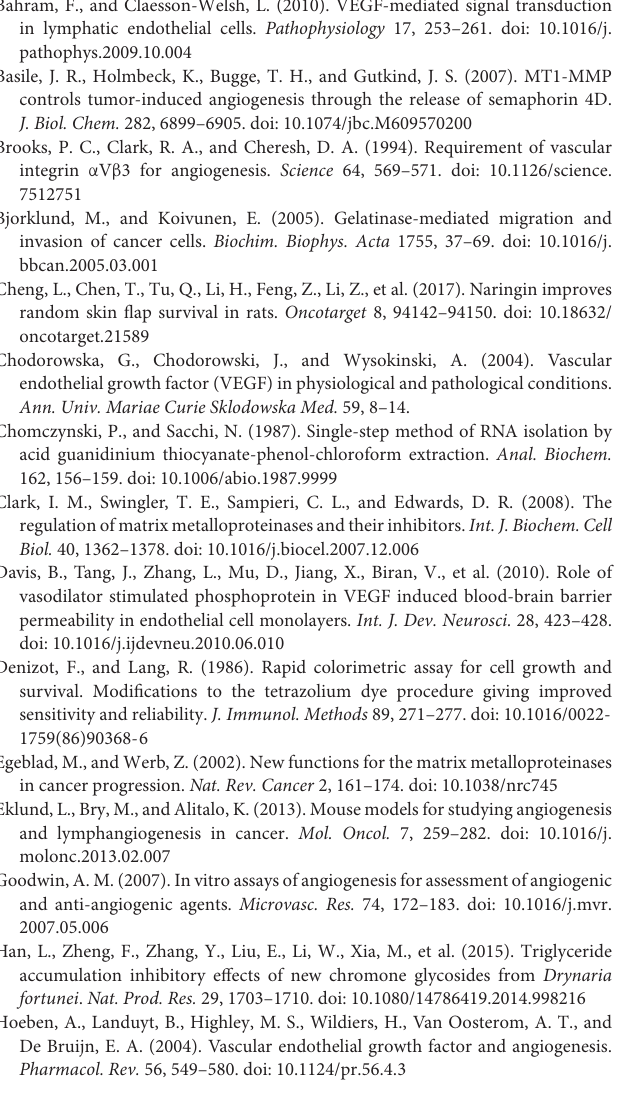
Holmes, D. I., and Zachary, I. (2005). The vascular endothelial growth factor (VEGF) family: angiogenic factors in health and disease. Genome Biol.